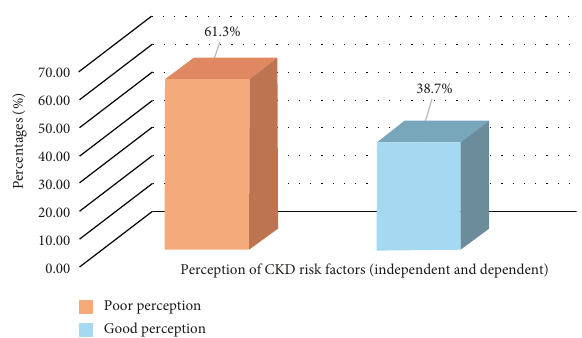
Figure 5: Level of perception of risk factors among